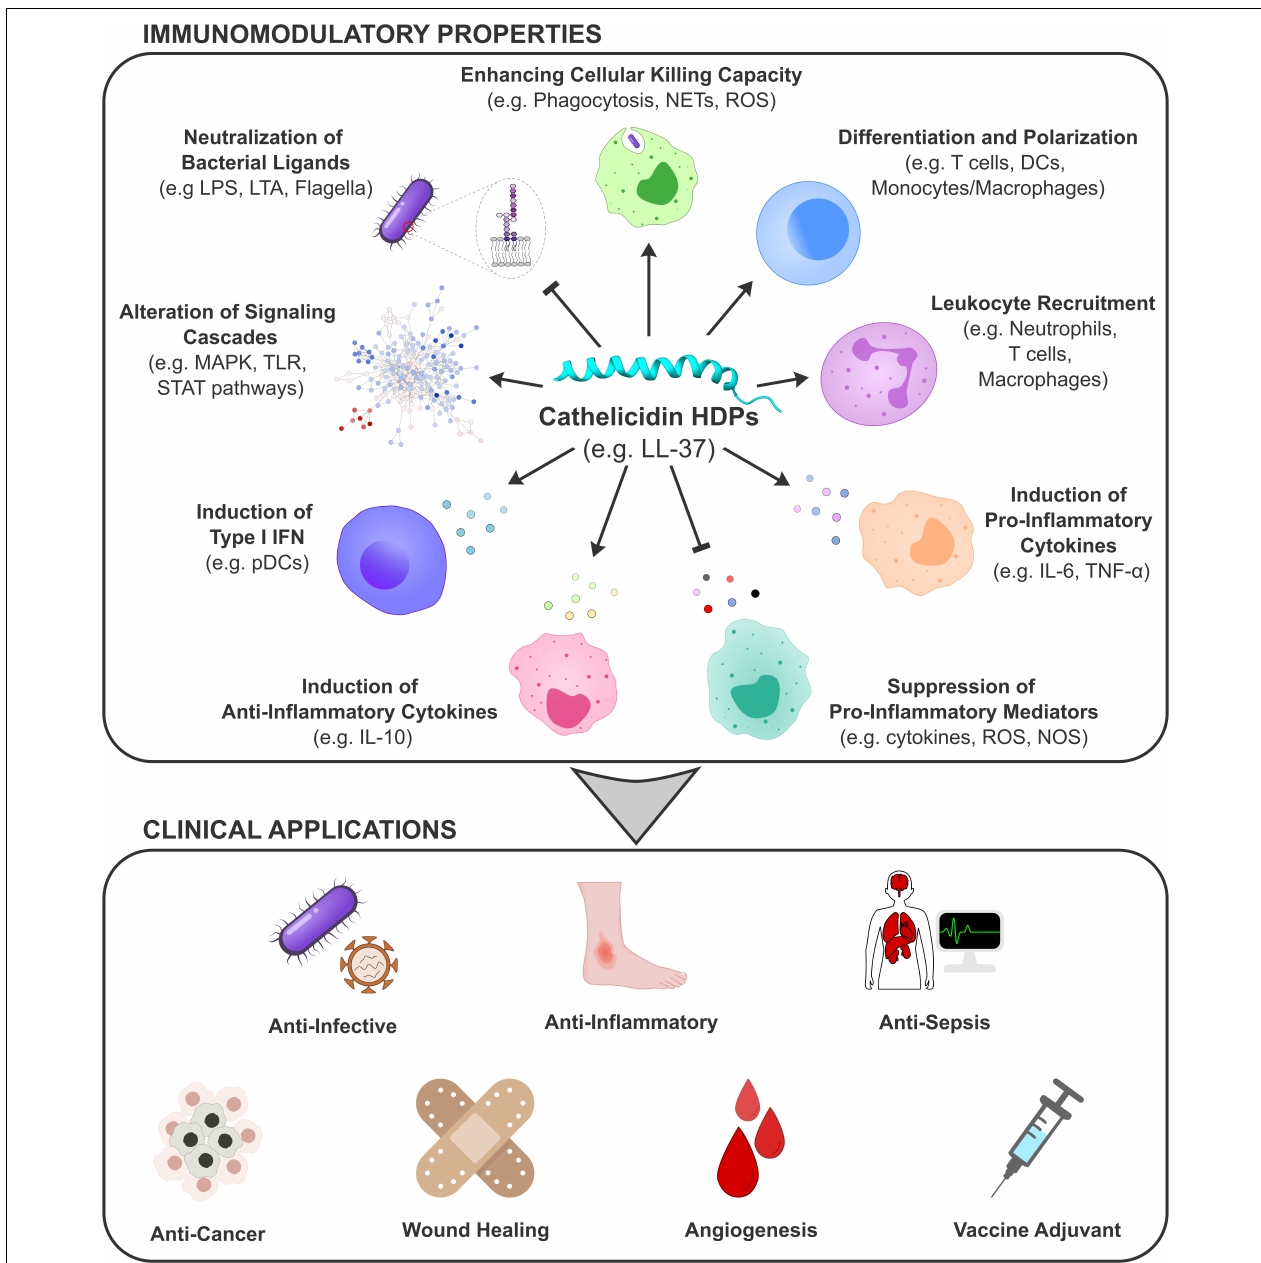
FIGURE 2 | The immunomodulatory features of cathelicidins. Immunomodulatory functions of cathelicidin HDPs include, but are not limited to: enhancing cellular killing capacity, differentiation and polarization of immune cells, leukocyte recruitment, induction or suppression of pro-inflammatory mediators, induction of anti-inflammatory cytokines, induction of type I IFN, alteration of signaling cascades and neutralization of bacterial ligands. These functions can be harnessed for anti-infective, anti-inflammatory, anti-sepsis and anti-cancer applications or contribute to wound healing, angiogenesis and improved vaccine effectiveness. DCs, dendritic cells; IFN, interferon; IL, interleukin; LPS, lipopolysaccharide; LTA, lipotechoic acid; MAPKs, mitogen-activated protein kinases; NOS, nitrous oxide species; ROS, reactive oxygen species; STAT, signal transducer and activator of transcription; TLRs, toll-like receptors; TNF, tumor necrosis